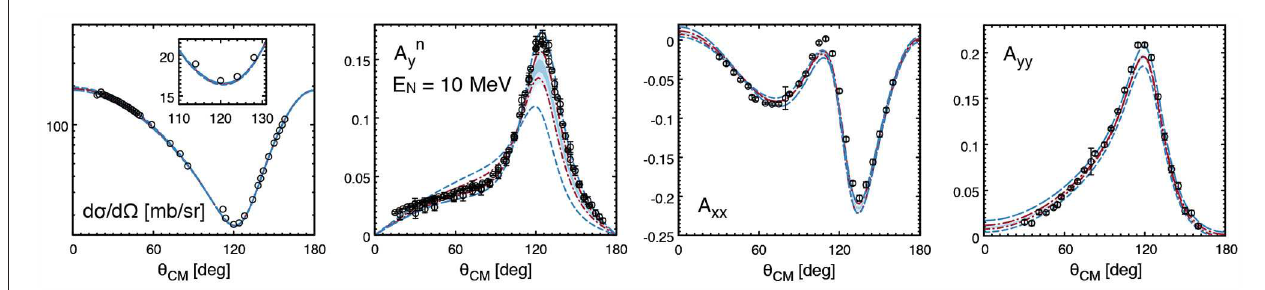
FIGURE 12 | Results for the differential cross section, nucleon analyzing powers A n y as well as deuteron tensor analyzing powers A xx and A xx in elastic nucleon-deuteron scattering at laboratory energy of E N lab 10 MeV based on the SMS NN potentials of Reinert et al. [17] at N 4 LO + in combination with the SMS 3NF = at N 2 LO using 3 450 MeV. Blue light- (dark-) shaded bands show the expected truncation uncertainty for a complete N 3 LO calculation and are obtained by = multiplying the N 2 LO truncation error corresponding to 95 % (68 % ) DoB intervals for the model ¯ C 650 0.5 Short-dashed-dotted and long-dashed-dotted red lines show the impact of the N 4 LO central short-range 3NF Similarly, short-dashed and long-dashed blue lines show the impact of the N 4 LO spin-orbit short-range 3NF circles are neutron-deuteron data from Howell et al. [187] and proton-deuteron data from Sagara et al. [188], Rauprich et al. [189], and Sperisen et al. [190], corrected for the Coulomb effects (see [44] for